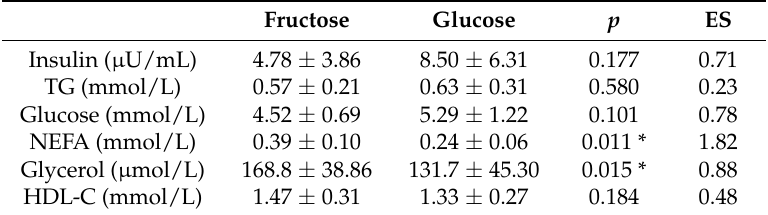
Table 2. The plasma and serum sample concentrations before OFTT. Fructose